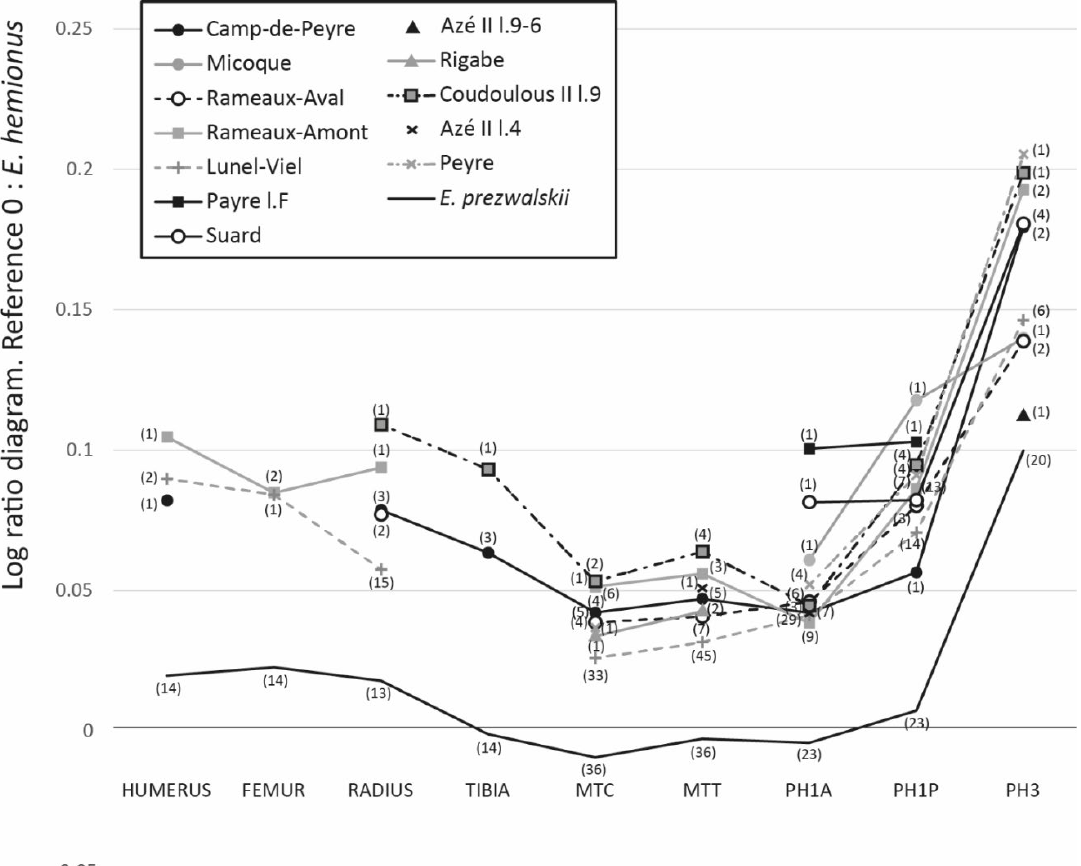
Figure 4. Log ratio diagram of humerus, femur, radius, tibia, third metacarpal and metatarsal, first anterior and posterior phalanges greatest length and third phalanx greatest width for caballoid horses from the South of France. Reference E. hemionus [78]. The number of specimens is indicated for each population. Camp-de-Peyre: E. m. campdepeyri ; La Micoque: E. mosbachensis ; Rameaux-Aval and Amont: E. mosbachensis ; Lunel-Viel: E. m. palustris ; Payre l.F: E. mosbachensis ; Suard: E. caballus piveteaui ; Pech de l’Az é II l.9-6: E. mosbachensis ; Rigabe: E. m. palustris ; Coudoulous II l.9: E. mosbachensis ; Pech